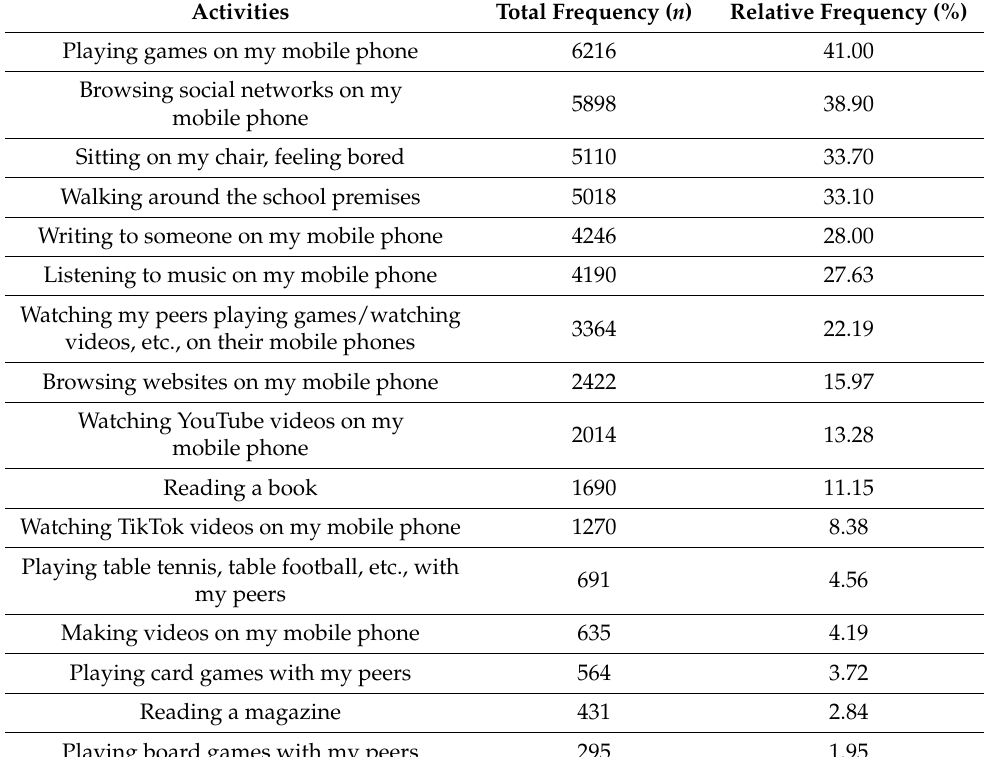
Table 3. The most frequent break time activities—schools where mobile phones are allowed during break